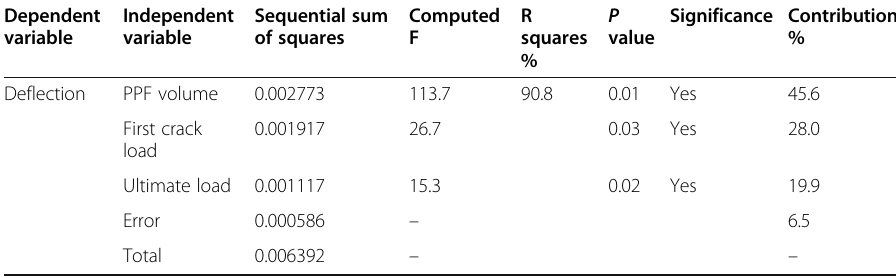
Table 7 Statistical evaluation of deflection of PPFGPCs Dependent